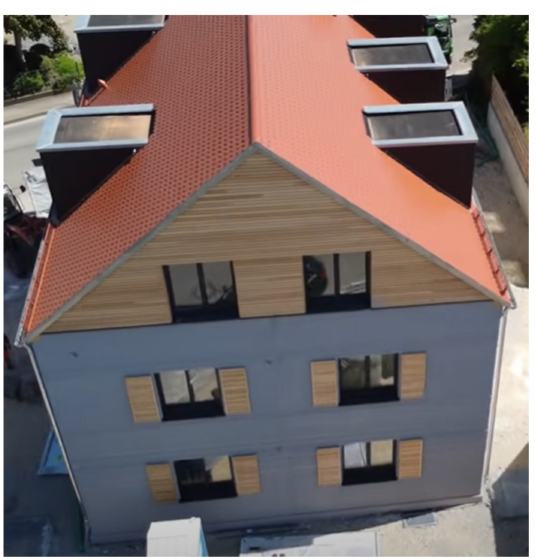
Figure 5. PERI’s completed apartment building in Germany [27]. Reprinted with permission from Ref. [27]. 2021, Jarett